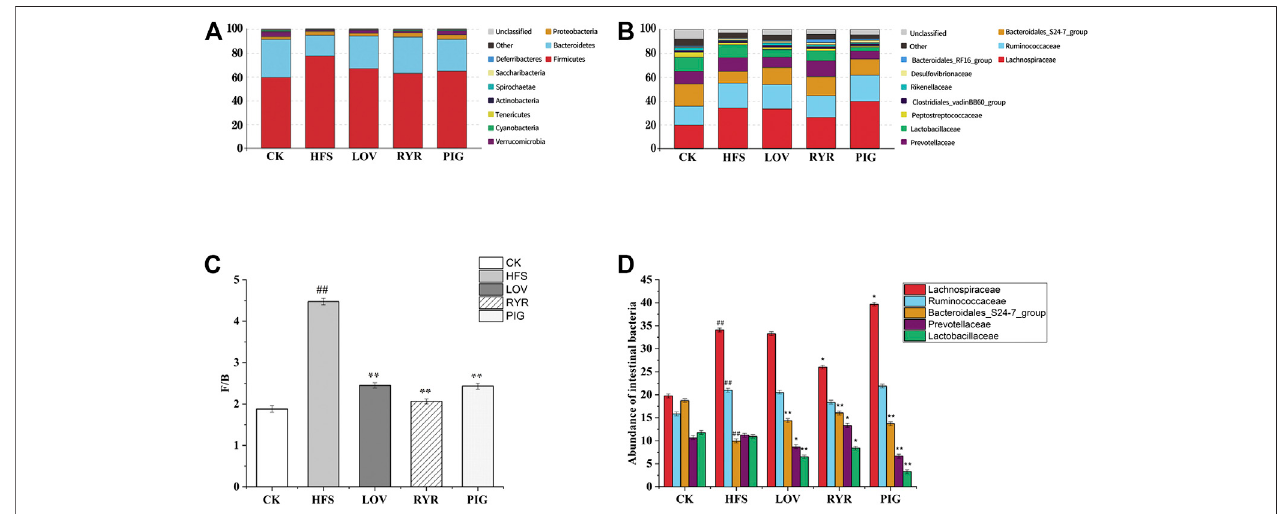
FIGURE8| Compositionofthegutmicrobiota(n (cid:2) 3). (A) Gutmicrobiotacompositionatthephylumlevel. (B) Gutmicrobiotacompositionatthefamilylevel. (C) F/B ratio (Firmicutes/Bacteroides). (D) Community abundance on phylum level.